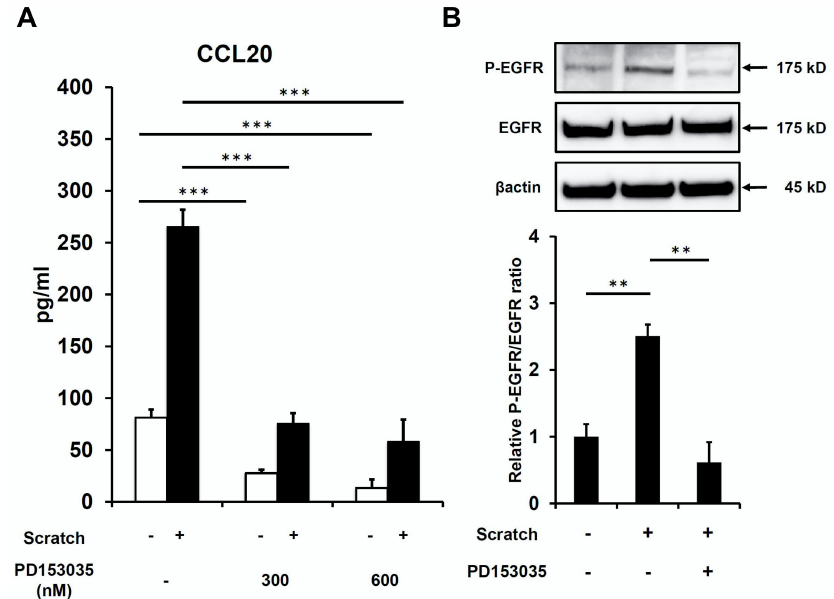
Figure 2. Scratch injury-induced CCL20 production depends on activation of epidermal growth factor receptor (EGFR). ( A ) Scratch injury-induced CCL20 production was measured in the presence or absence of PD153035 (EGFR inhibitor, 300 or 600 nM) at 24 h after scratching. ( B ) The phosphorylation of EGFR (P-EGFR) was measured by western blot analysis at 1 h after scratching. Representative enzyme-linked immunosorbent assay (ELISA) data and Western blot images of three independent experiments are shown. ** p < 0.01. *** p <